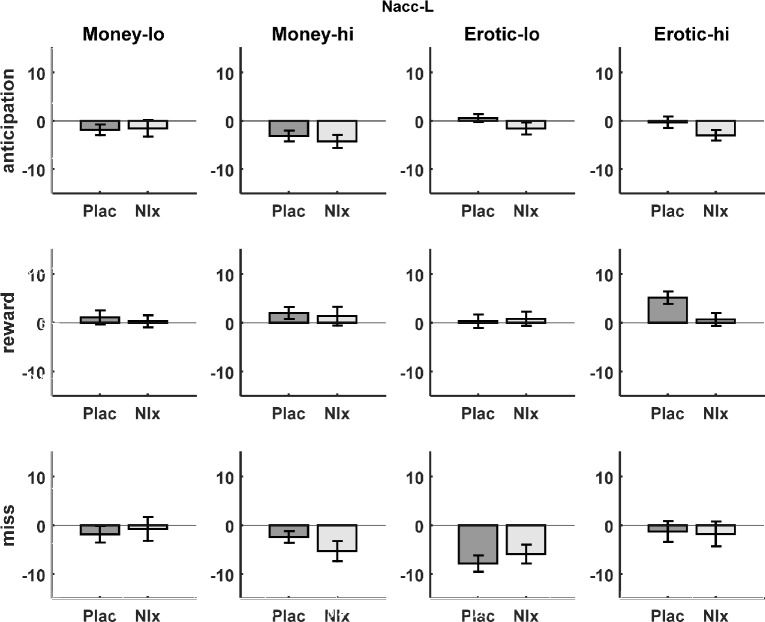
Left ventral striatum (nucleus accumbens) fMRI responses (arbitrary units) for all stimuli (money/erotic, high/low) and time-points (anticipation, outcome: reward, outcome: miss) under placebo (Plac) and naloxone (Nlx).Error bars represent standard error of the mean.